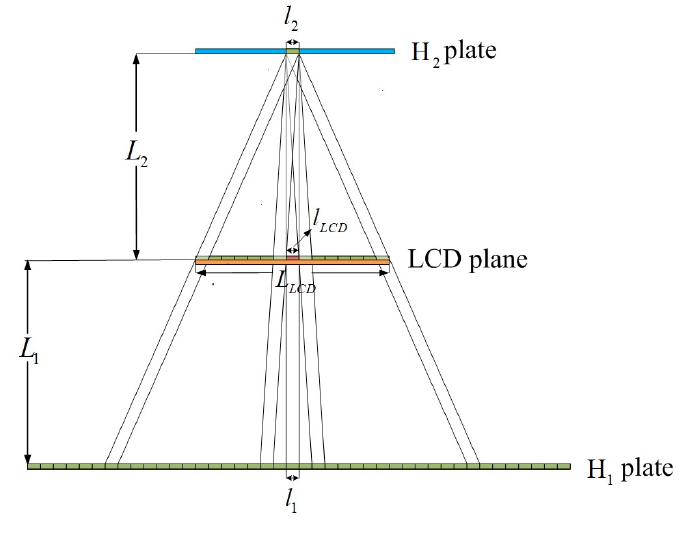
Figure 6. Parameter setting of holographic element-based EPISM